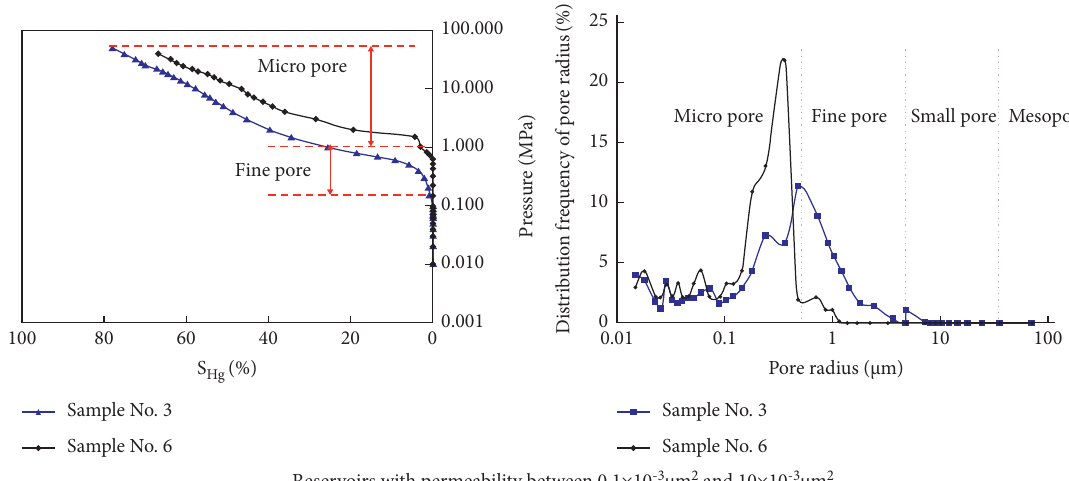
Figure 2: Capillary pressure curves and pore distribution characteristics of different types of